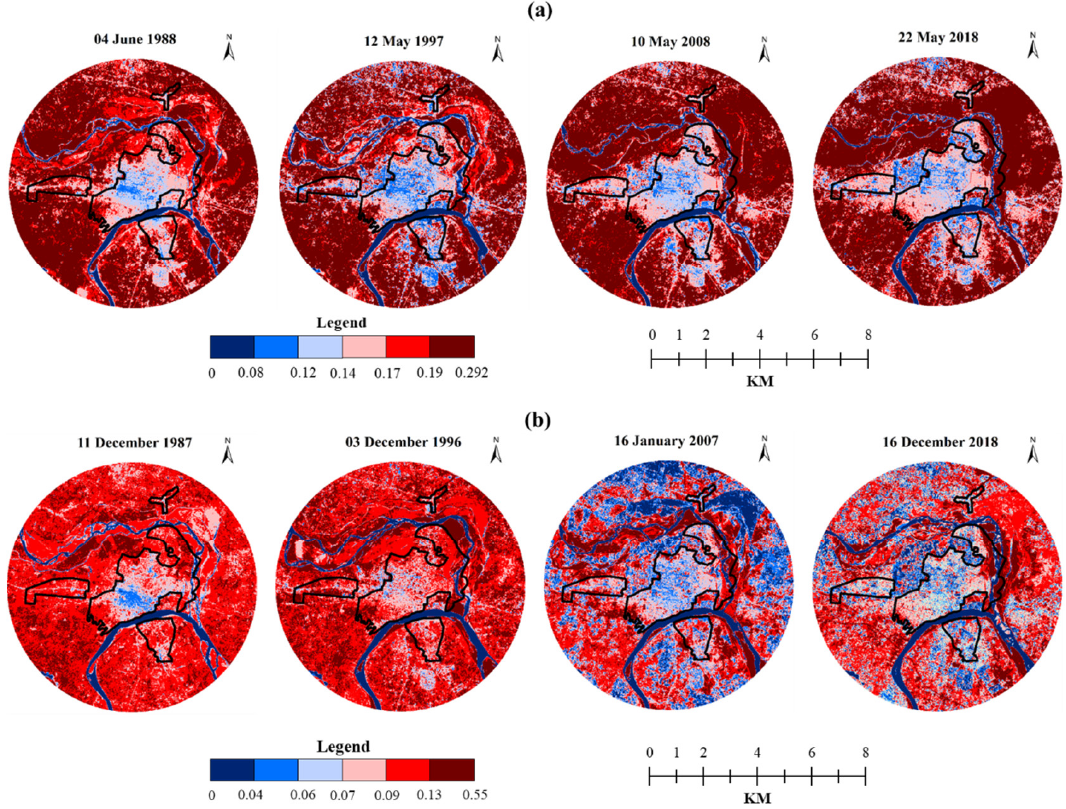
Figure 8. Seasonal EBBI dynamics in Prayagraj city (1987–2018): ( a ) summer and ( b ) winter. A positive correlation was detected between LST vs. EBBI at all distinctive sum- mer/winter time points (Figures 13 and 14). The role of EBBI in LST intensification re- mained high in both the summer and the winter (Table 6). This indicates that the imper- ing in increased temperature growth due to the conversion of forests, water bodies,